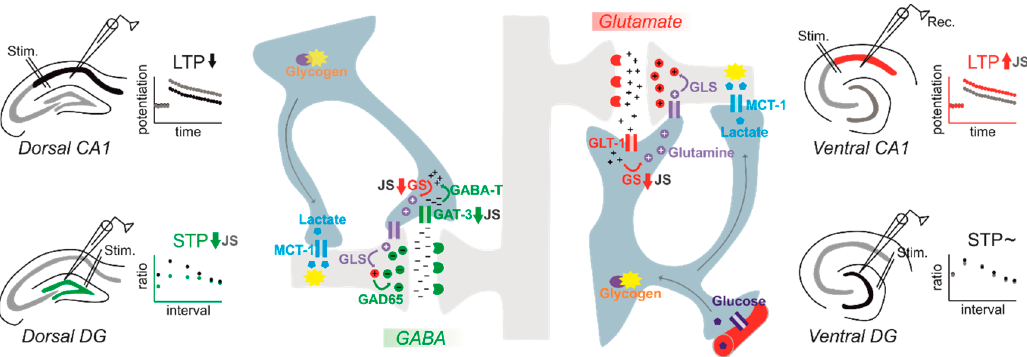
Figure 1. Juvenile stress lastingly affects neuron–astrocyte interactions, which are linked to region-specific changes in short- and long-term plasticity in the hippocampus. Exposure to variable stress during juvenility (JS) lastingly reduces the expression of the astrocyte-specific gamma-aminobutyric acid (GABA) transporter GAT-3, leading to increased inhibition/reduced facilitation in short-term plasticity (STP) protocols (see left side, green). This effect was specifically observed in the dorsal dentate gyrus (DG; see left side, green), while no changes were observed in the ventral DG (see right side). Indeed, reduced astrocytic uptake of GABA would increase inhibition at neuronal synapses. Within astrocytes, GABA is further converted to glutamate via the enzyme GABA transferase (GABA-T). Glutamate is then converted to glutamine via glutamine synthetase (GS) and shuttled back to neurons, where new glutamate is synthetized by the enzyme glutaminase (GLS). In inhibitory neurons, Glutamate decarboxylase GAD65 (and the isoform GAD67) converts glutamate to GABA. The glutamate/glutamine cycle is also active in astrocytes around glutamatergic synapses (right side, red), where glutamate is taken up into astrocytes by the transporter GLT-1. Interestingly, within the ventral CA1 subregion of the hippocampus, expression of GS was reduced, leading to increased LTP specifically in this region (right side, in red), while dorsal CA1 LTP is reduced by JS (left side, black; the association with astrocyte-neuron-interaction is unclear). Next to neurotransmitter uptake, astrocytes interact with neurons in multiple ways. For example, in contrast to neurons, astrocytes can store glucose by transforming it to glycogen and provide neurons with lactate as a source of energy. Lactate is shuttled to neurons via specific transporters, e.g., monocarboxylate transporter 1 (MCT1). While the blocking of MCT-1 has been shown to affect LTP and memory, the impact of JS on this system is still unclear and remains to be investigated in future.